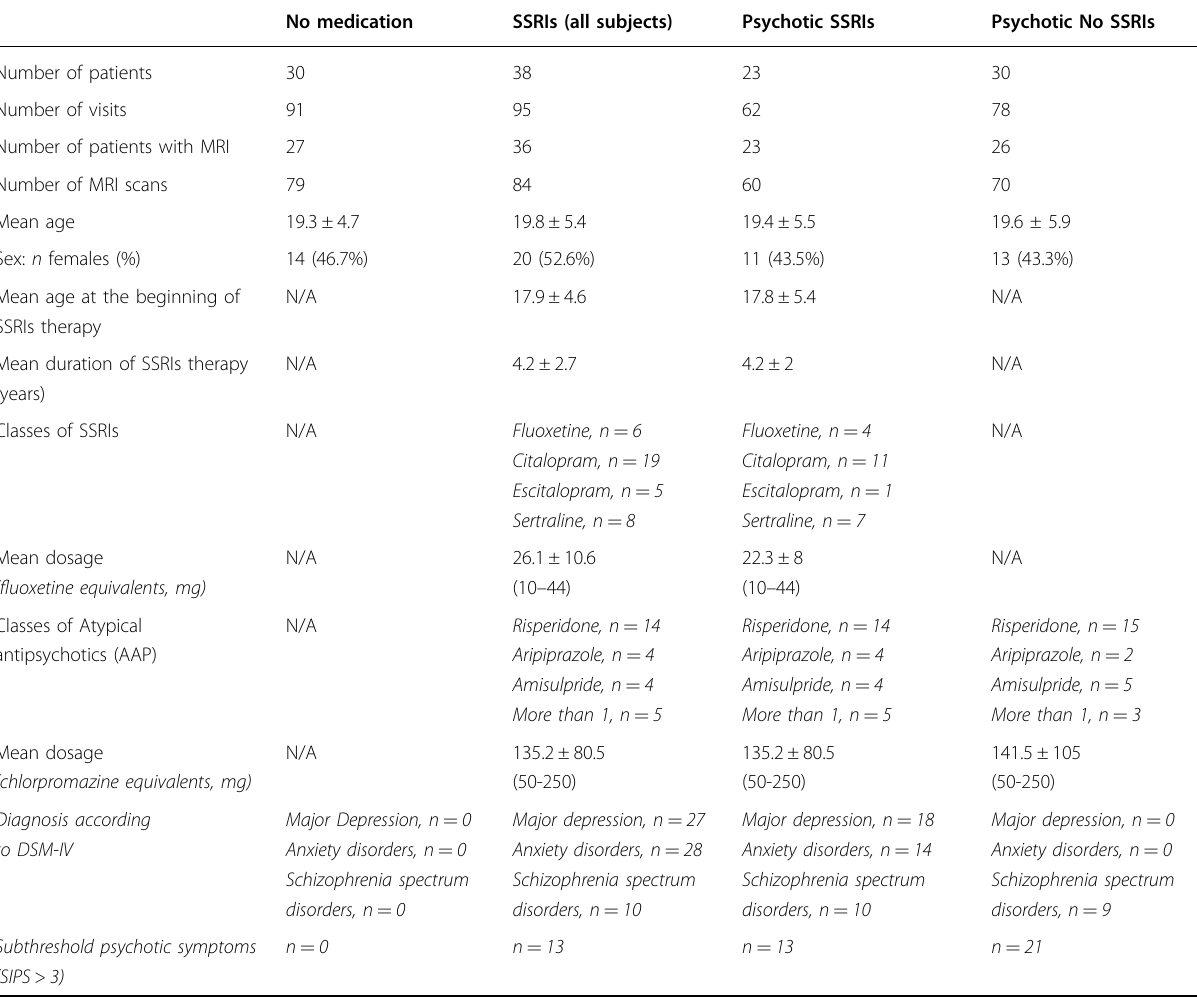
Table 1 Demographic and clinical information of the main groups and